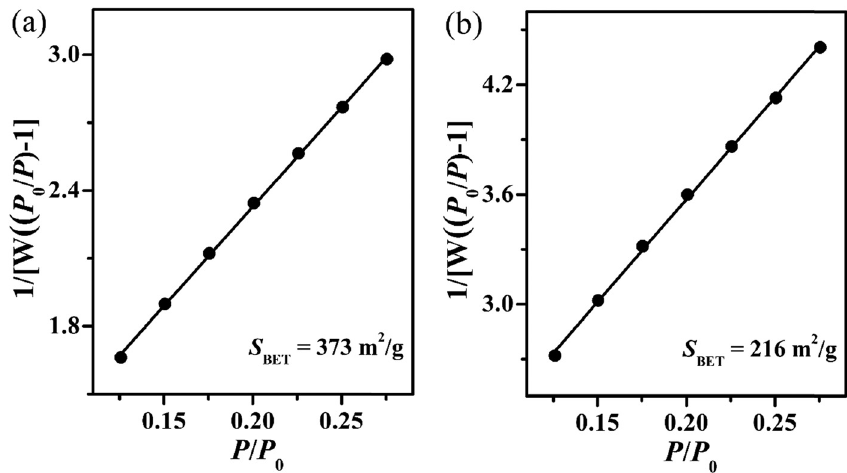
Figure A3: BET linear plots of ( a ) TBrTh – BTBPE – CTF and ( b ) CTF – TMZ.